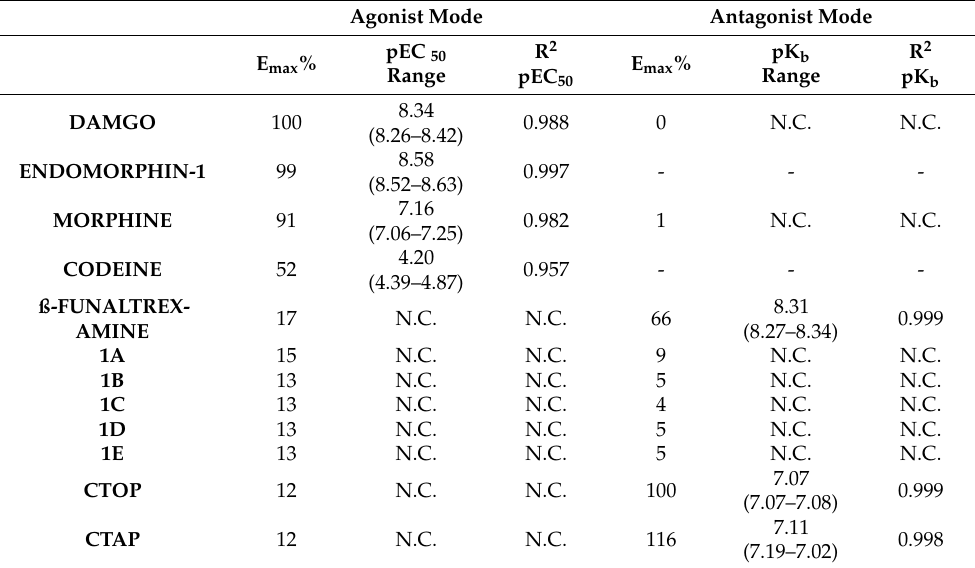
Table 3. Effect of the tested compounds on the intrinsic activity of the MOP. Functional data from the cAMP assay in the agonist and antagonist modes.